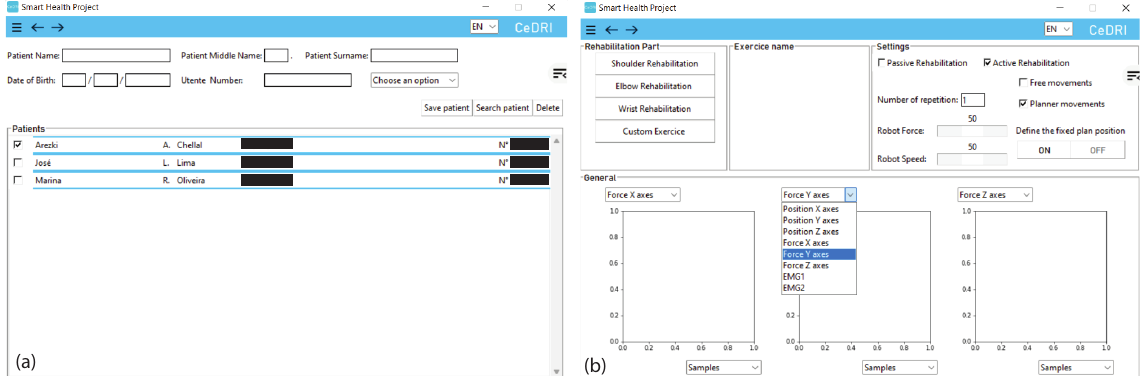
Figure 2. SmartHealth, control software graphical interface in an idle state. ( a ) Patient tab, with the different patient registered in the software. ( b ) Setting tab, with a slide showing the different parameters that can be